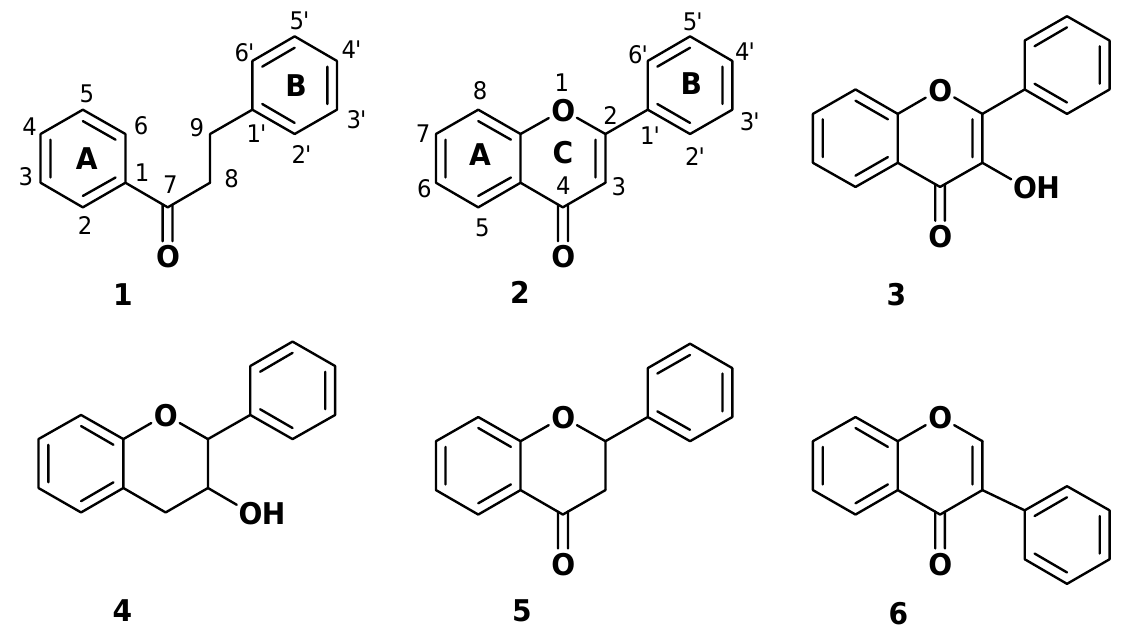
Figure 1. Structure and numeration of flavonoids